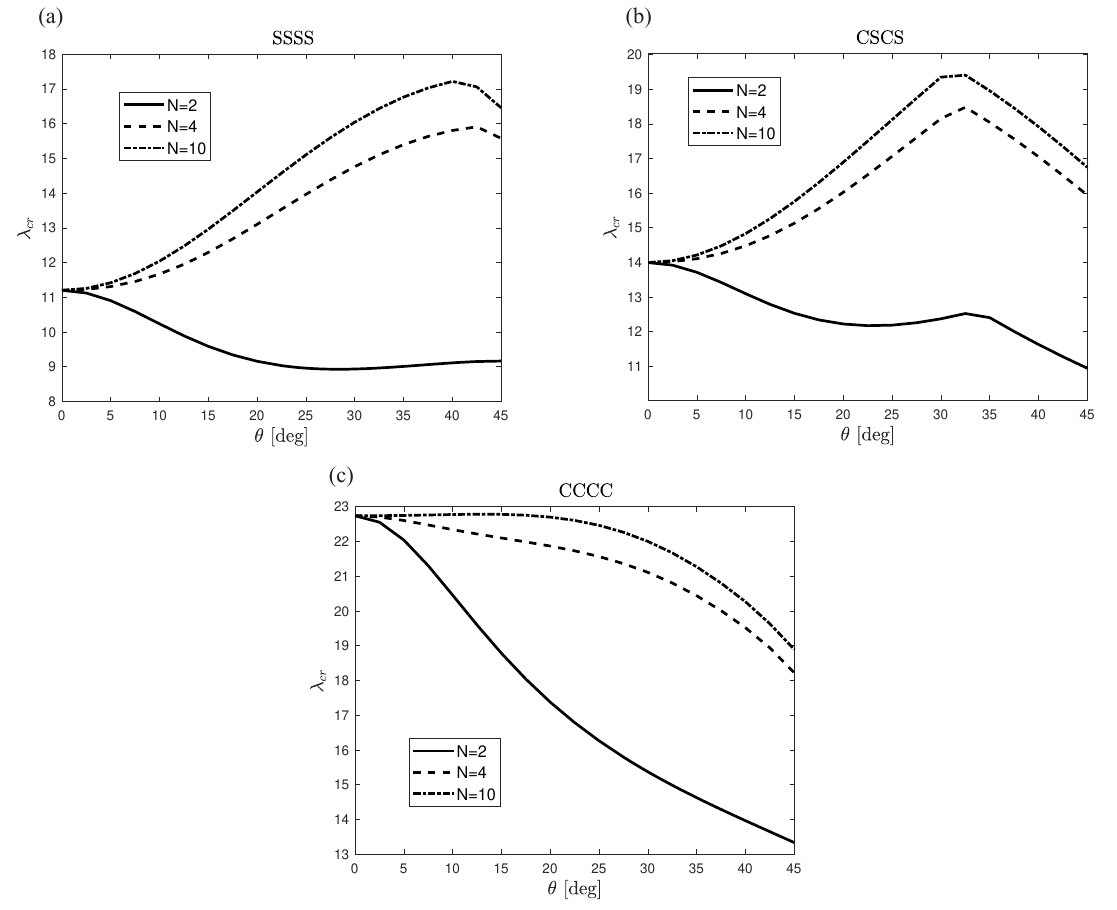
Fig. 2. Uniaxial buckling parameters for L2 squared plates.